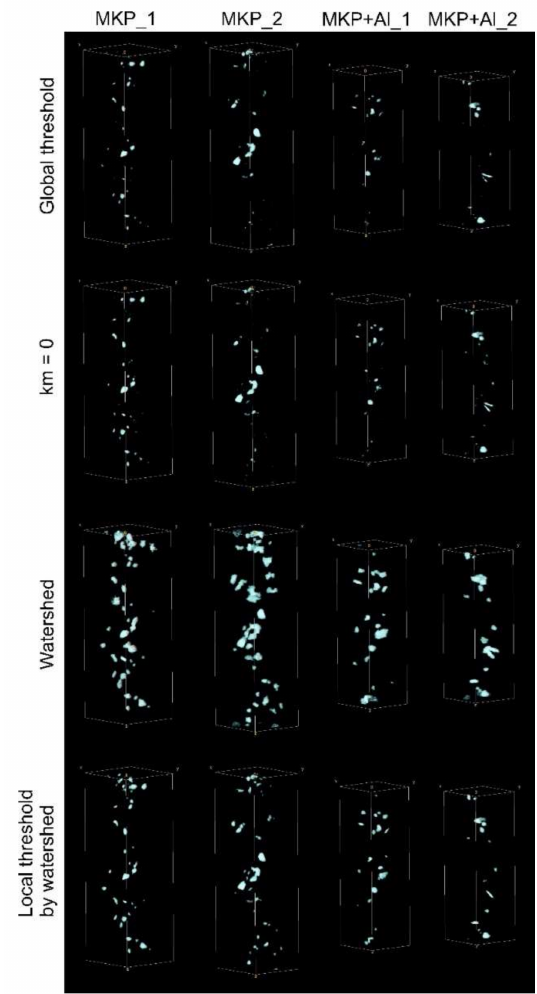
Figure 5. Three-dimensional models of spatial distribution of the segmented pores in the studied cement samples obtained by means of different segmentation